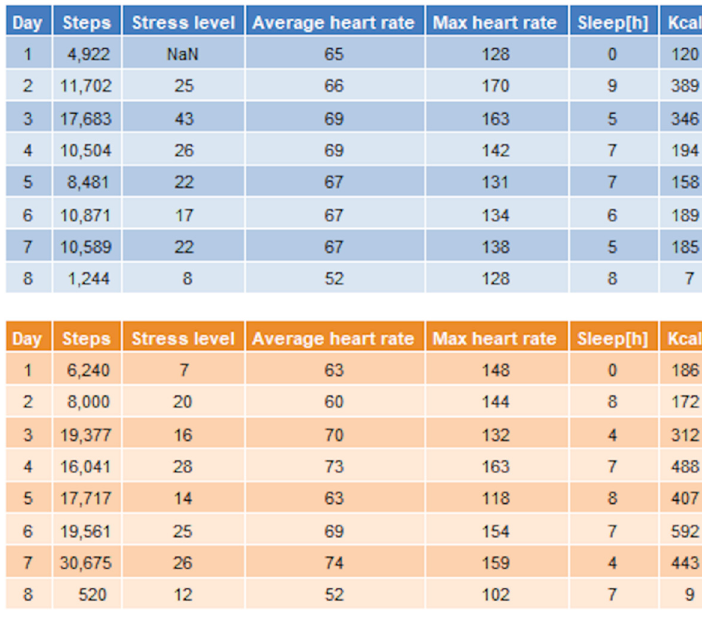
Figure 7. Aggregated data from SAT.